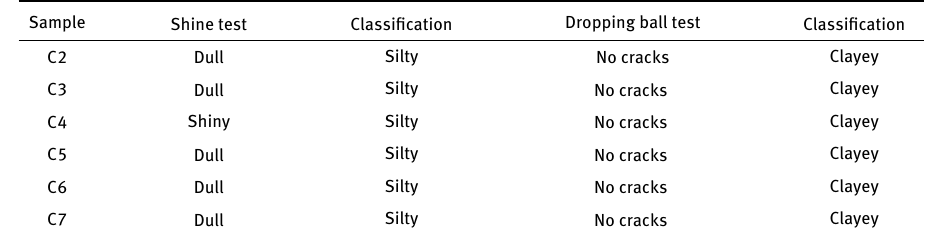
Figure 7: Shine, dropping ball, adhesion and water retention tests. Table 5: Shine and dropping ball test. Sample